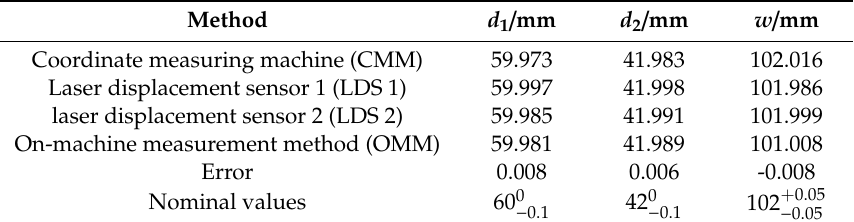
Table 3. Comparison table of measuring results through di ff erent measuring